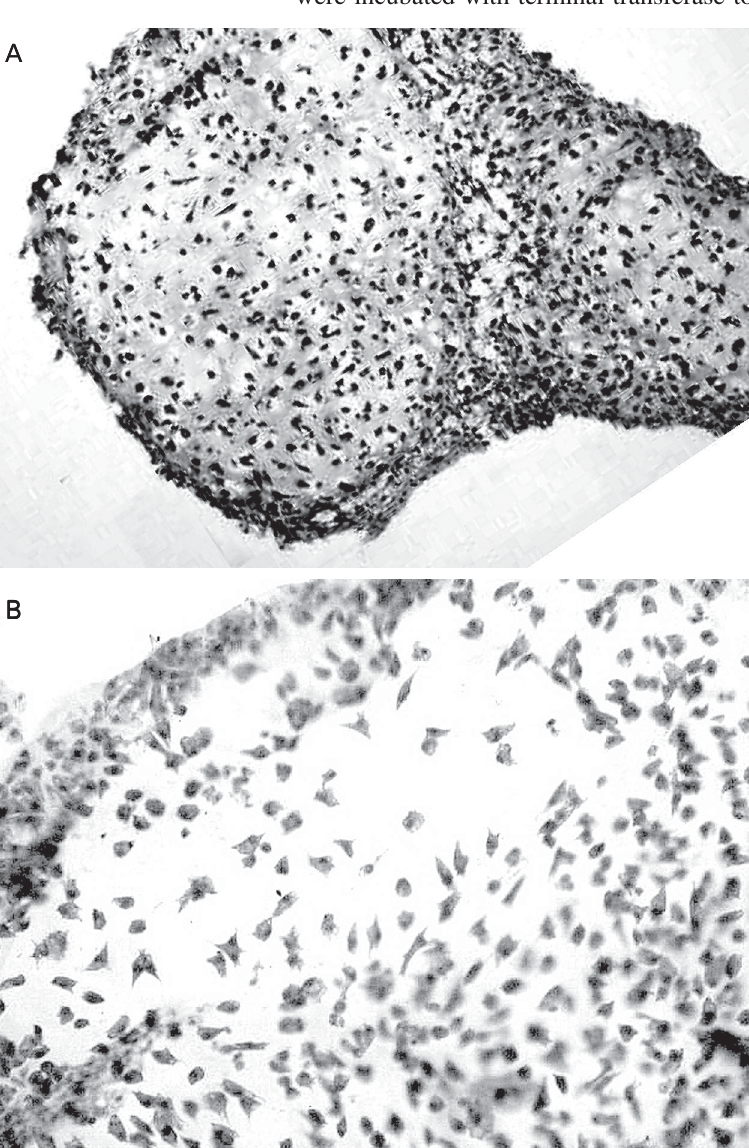
Figure 1. Micromass culture morphology and extracel- lular matrix deposition at day 21. A , Well-organized cartilage nodules resembling cartilage in vivo were formed in 1% FCS control cultures. B , In contrast, in insulin-treated cultures hypertrophic cells are scarce and the nodular organization is lacking, suggesting im- paired cell maturation. Hematoxylin-eosin. Final magni- fication: 10X (A) and 40X